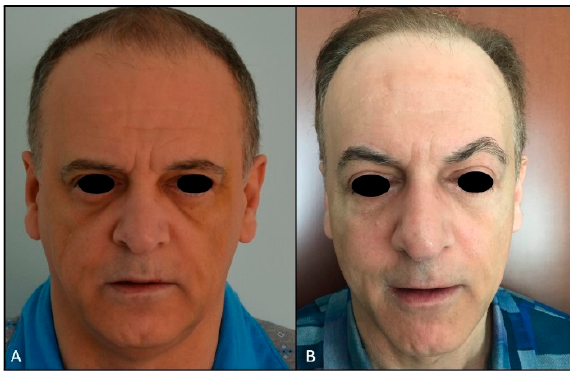
Figure 7. Pre-operative ( A ), and three-year follow-up ( B ) result of a 54-year-old patient having sub-malar implant placement. During the same operating time, forehead lift, brow lift, and CO2 forehead treatment were also performed.